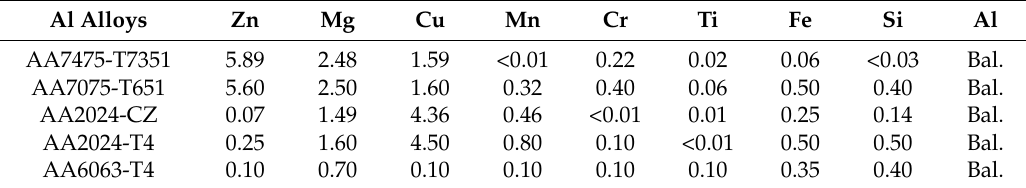
Table 2. Chemical compositions (wt. %) of representative aluminum